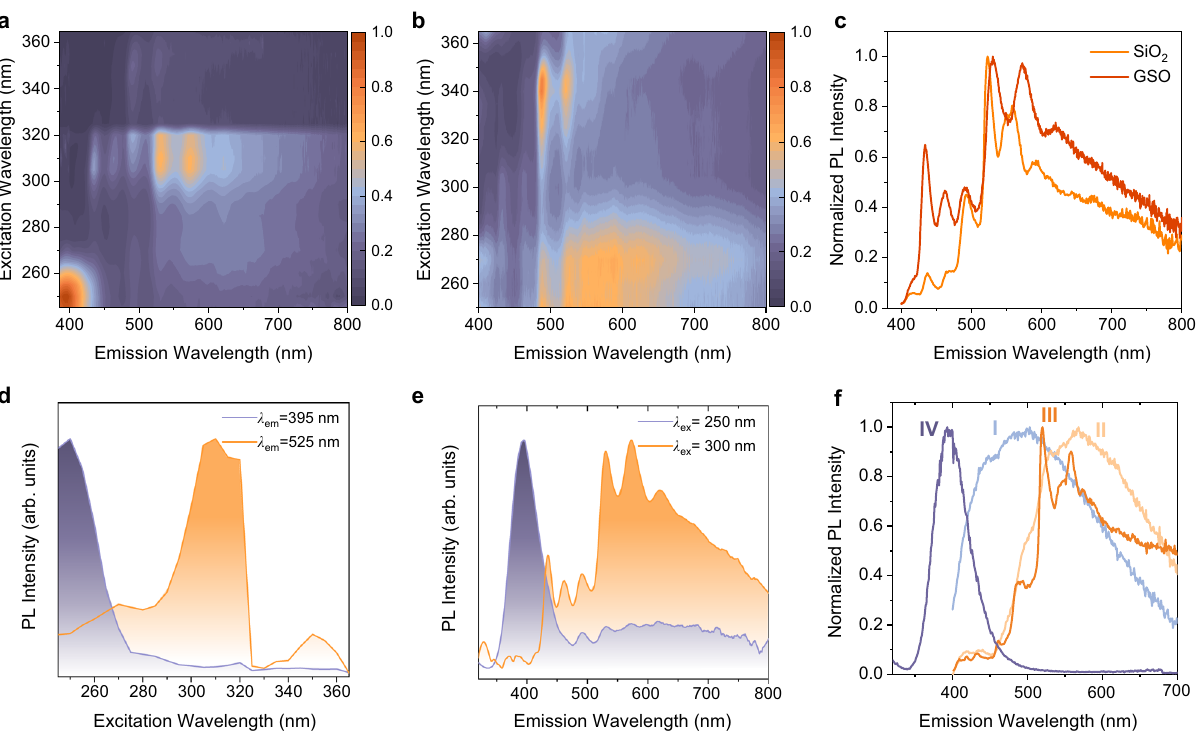
Fig. 2 | Excitation-wavelength-dependent colour tuning in GSO. Excitation- emission matrix ( EEM) spectraof ( a ),Sample III and ( b ), pristine silica measured at room temperature under ambient conditions. Colour bars show normalized PL intensity. c Normalized PL spectra of pristine silica and Sample III under the same annealing procedure. Excitation wavelength = 300nm. d PL excitation (PLE)